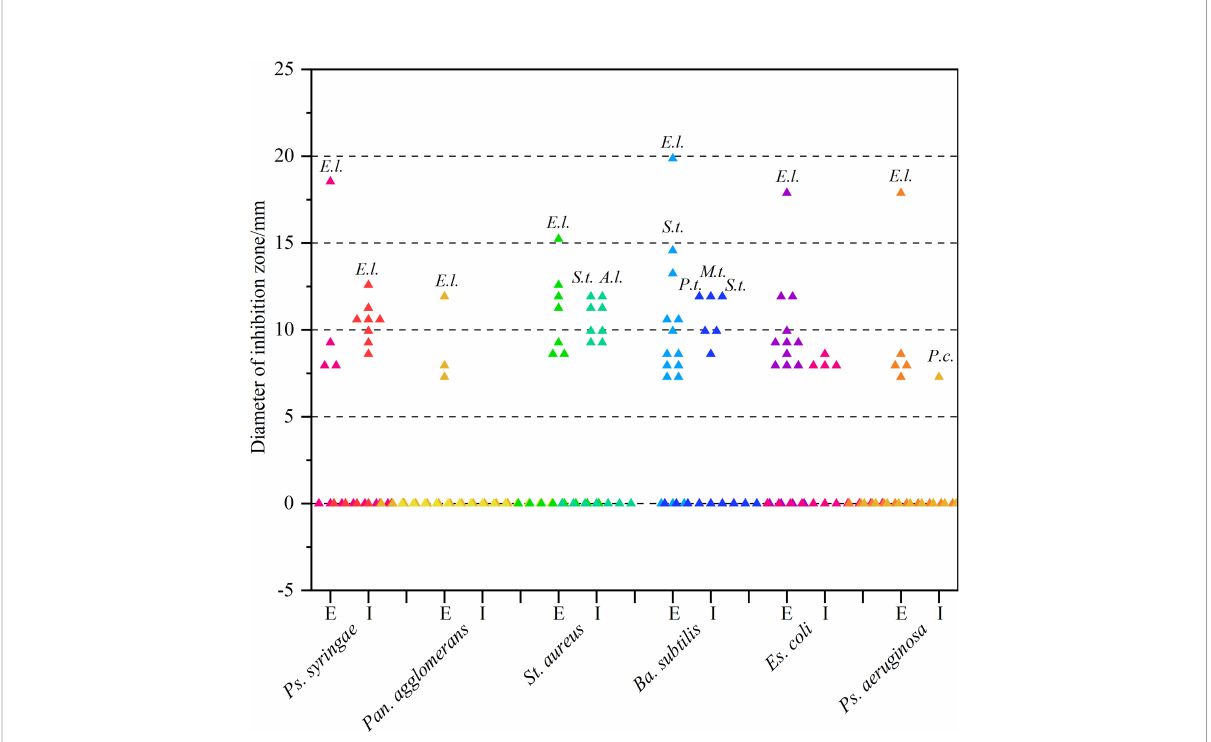
FIGURE 3 Results of re-screening for antibacterial activity. E and I indicate extracellular and intracellular metabolites, respectively. A.l. , E.l. , M.t. , P.c. , P.t. , and S.t. stand for Alternaria longipes HGUP192022, Epicoccum latusicollum HGUP191049, Mycoleptodiscus terrestris HGUP190018, Penicillium crustosum HGUP190031, Phyllosticta telopeae HGUP192003, and Setophoma terrestris HGUP190028,